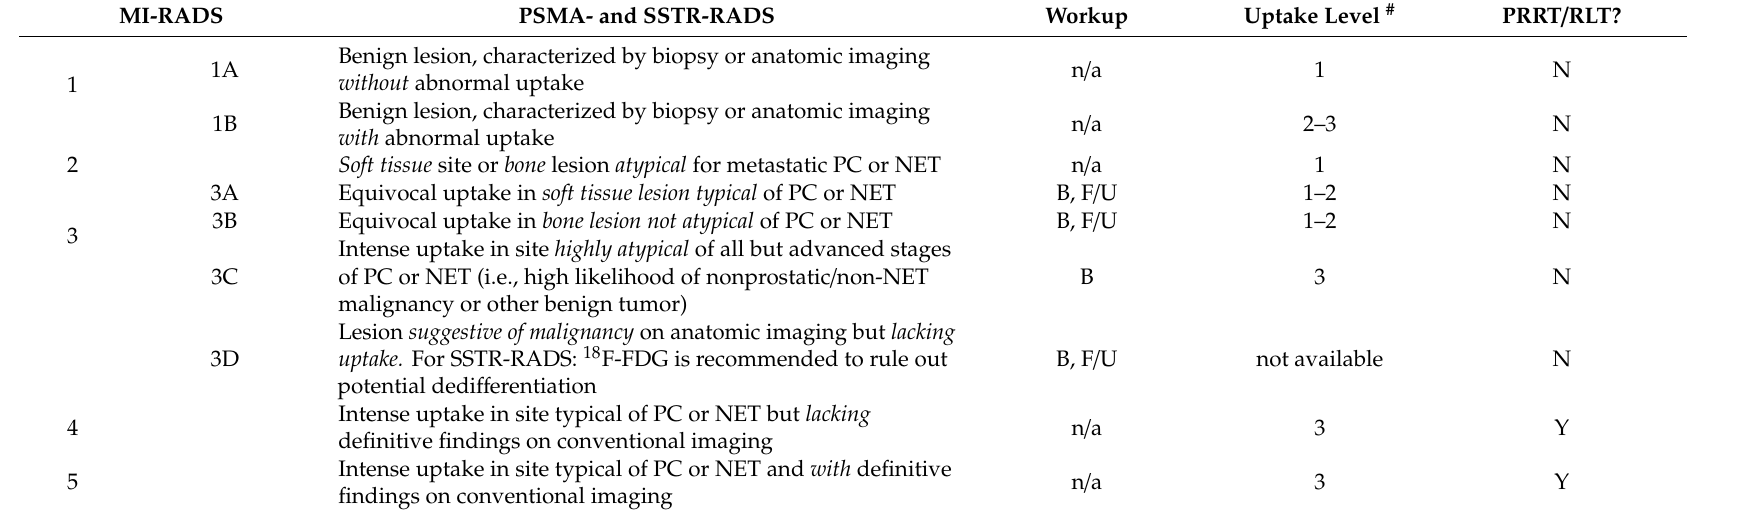
Table 1. Reporting and data systems (RADS) in molecular imaging (MI-RADS), consisting of prostate-membrane specific antigen (PSMA)-RADS and somatostatin receptor (SSTR)-RADS. n / a = not applicable, N(o) = peptide receptor radionuclide therapy (PRRT) / radioligand therapy (RLT) not recommended. B = Biopsy, F / U = follow-up imaging (3–6 months, e.g. depending on Ki67 in NET). Y(es) = PRRT / RLT recommended. # = applies only to SSTR-RADS, defined as 1 (focal uptake, but ≤ blood pool) through uptake level 2 ( > blood pool, but ≤ physiologic liver uptake) to uptake level 3 ( > physiologic liver uptake). Modified from Werner et al.